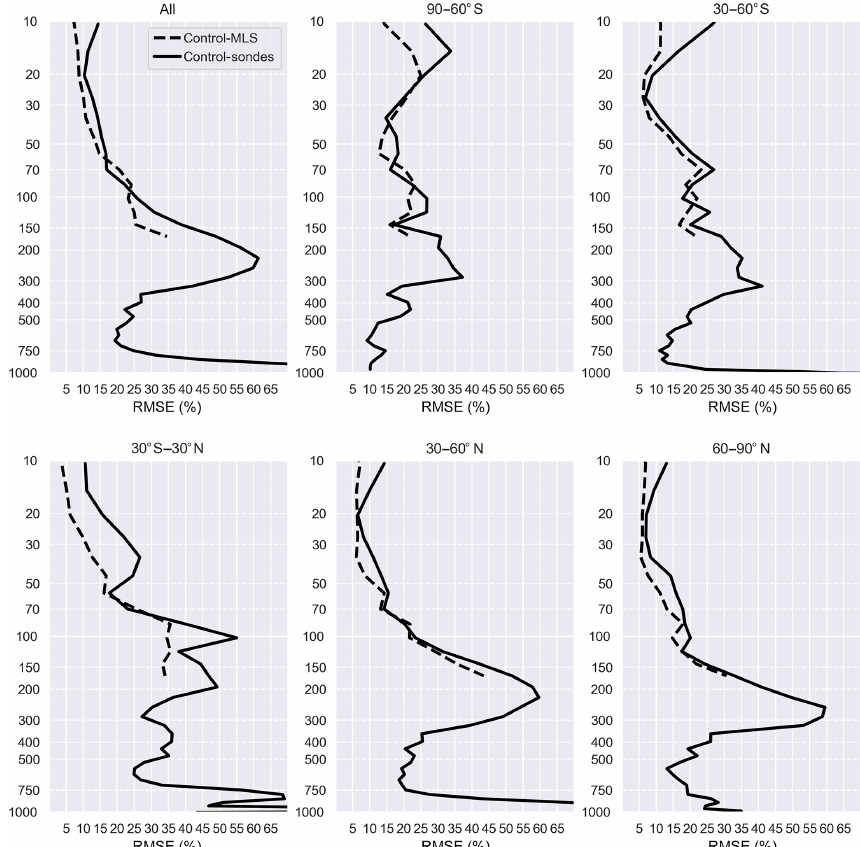
Figure 3. Relative root mean square error (RMSE) of the control simulation with respect to radiosoundings (solid lines) and MLS (dotted lines) averaged globally (first plot) and for five separate latitude bands (90–60 ◦ S, 60–30 ◦ S, 30 ◦ S–30 ◦ N, 30–60 ◦ N, 60–90 ◦ N). To compute the percentage, the RMSE statistics have been divided by the corresponding average profile of the observations (radiosoundings or MLS) for each